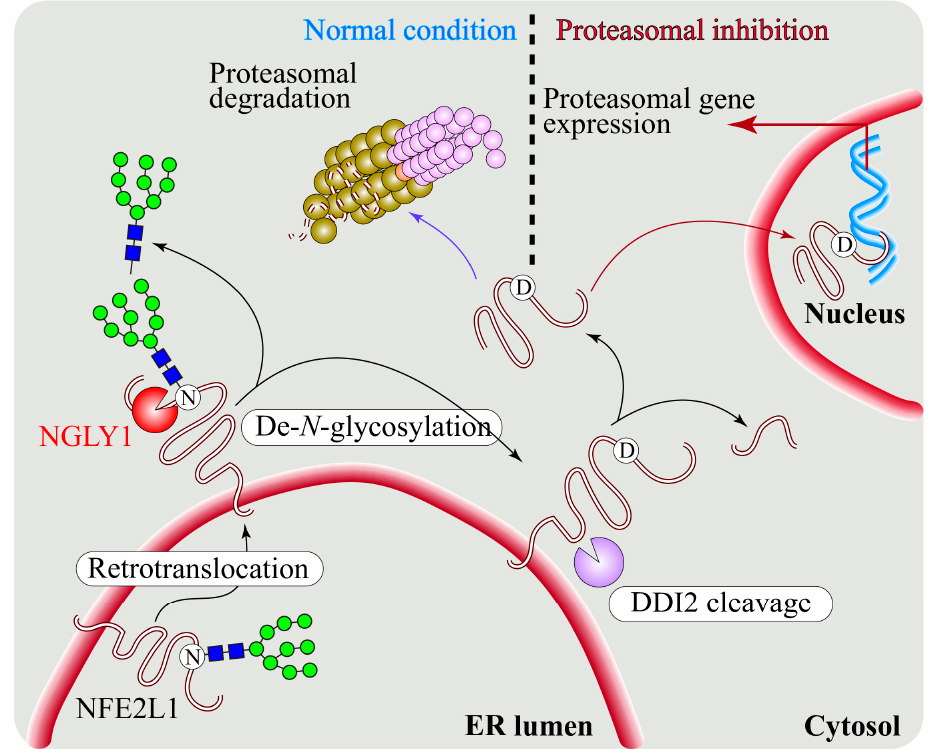
Figure 4. Schematic representation showing that under normal conditions, retrotranslocation from ER to cytosol directs NFE2L1 to its proteasomal degradation. Upon proteasomal inhibition, NFE2L1 undergoes de- N -glycosylation by NGLY1 and is cleaved by an aspartic protease called DNA damage-inducible 1 homolog 2 (DDI2), which leads to its activation. Activated NFE2L1 enters the nucleus and induces the transcription of proteasomal subunit genes, as well as its other target genes. N, asparagine; D, aspartic acid.